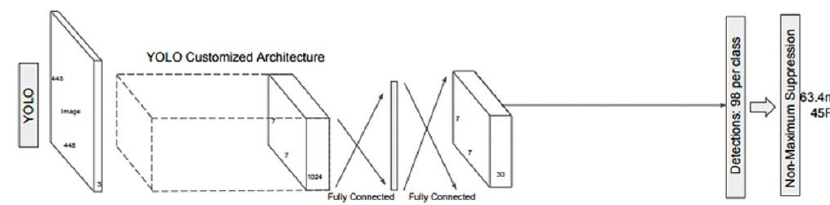
Figure 2. YOLO model [43].